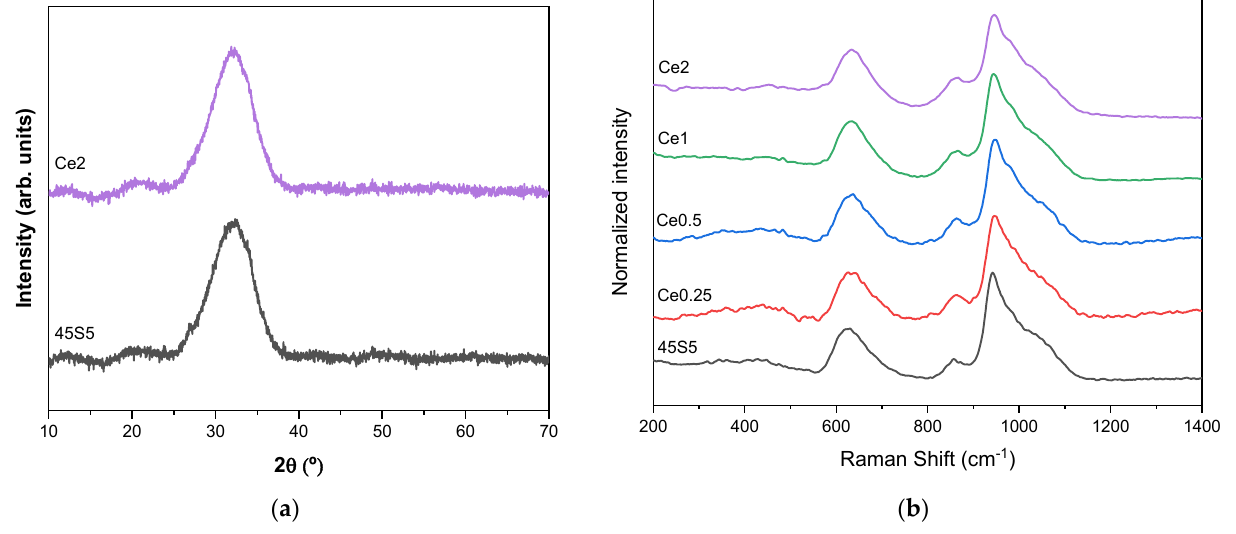
Figure 3. ( a ) XRD patterns of the 45S5 and Ce2 samples, and ( b ) Raman spectra of the 45S5, Ce0.25, Ce0.5, Ce1 and Ce2 samples.